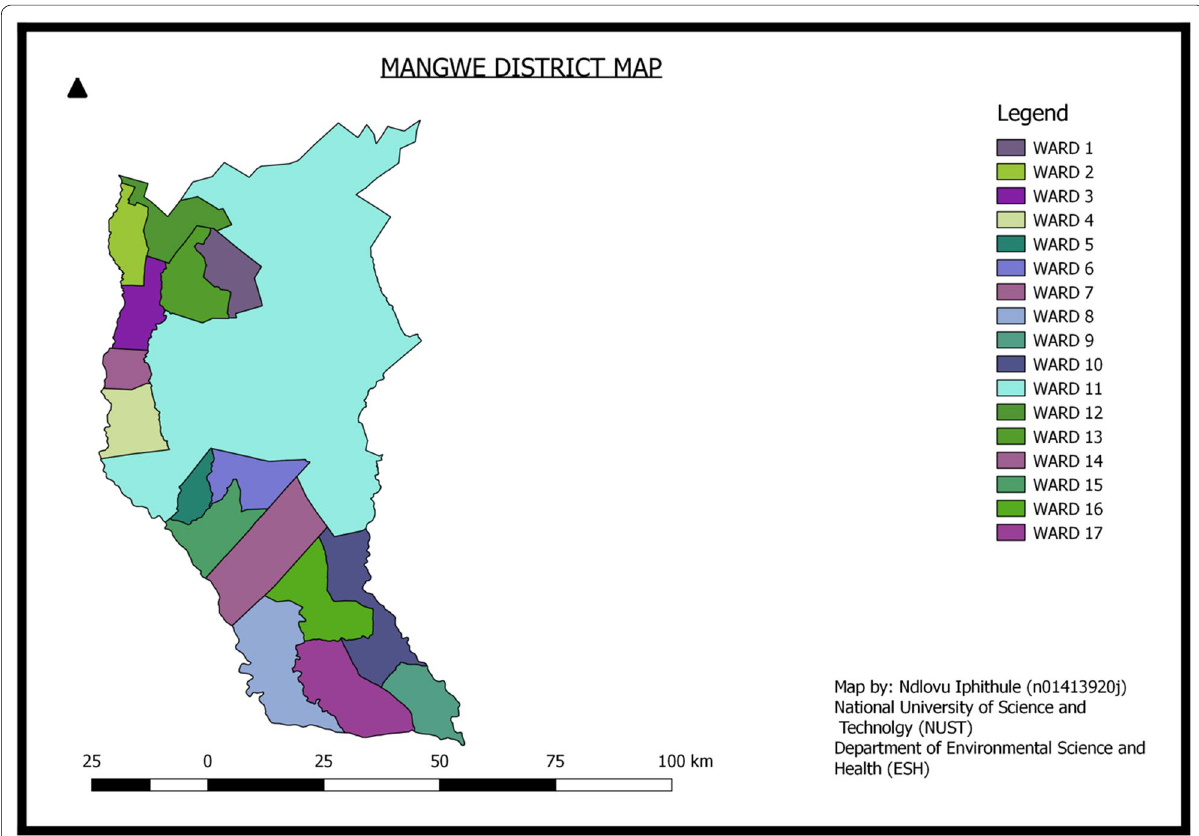
Fig. 1 Study area map (Mangwe District showing all